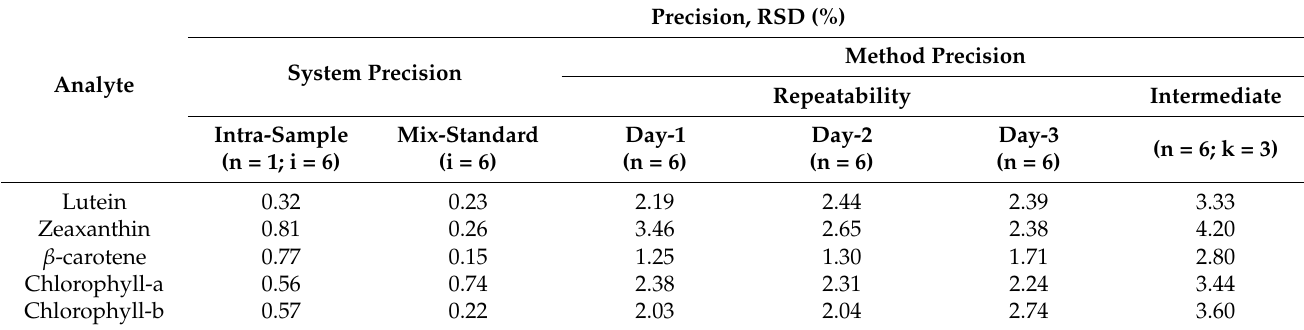
Table 3. Intra- and inter-day method and system precision obtained in samples by the HPLC-UV method